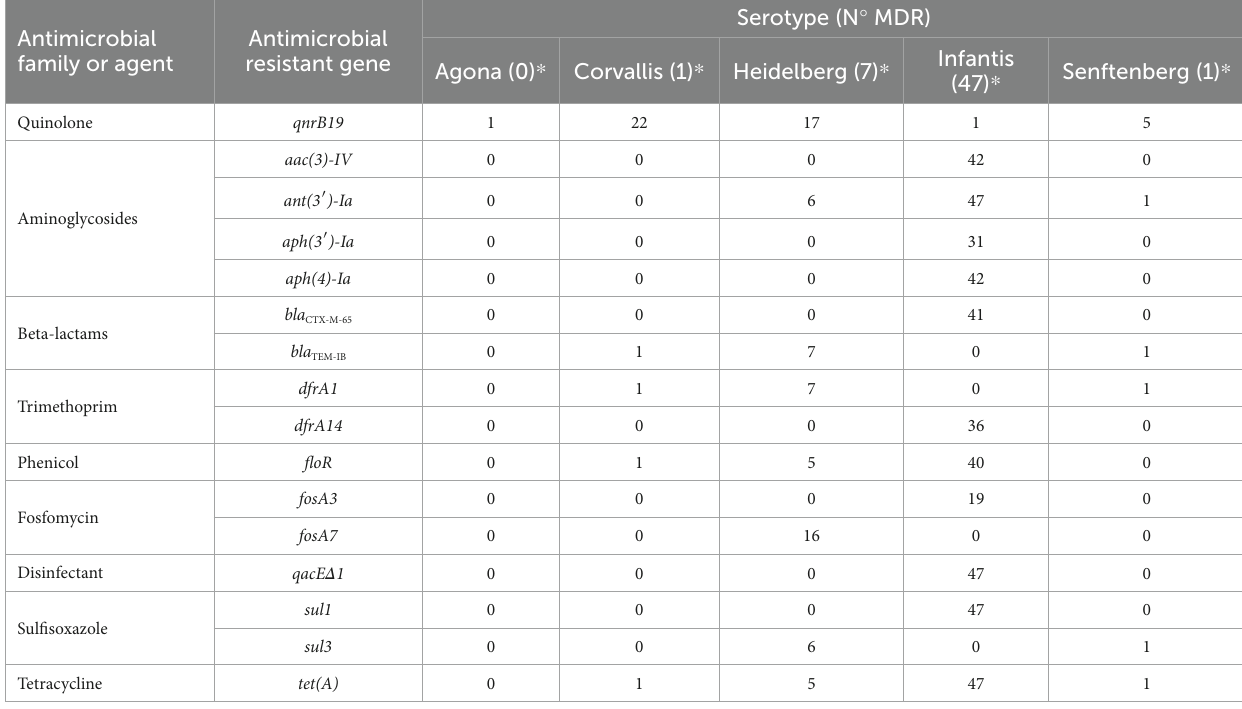
Antimicrobial family or